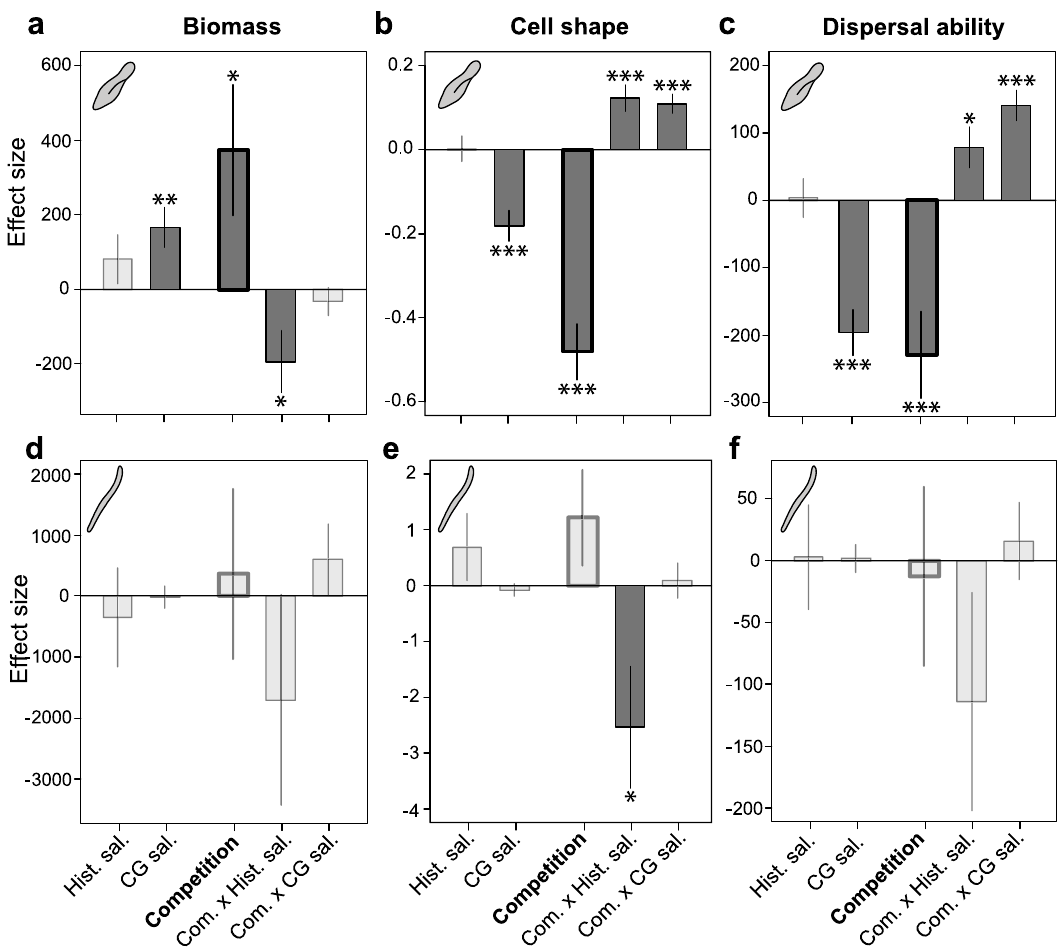
Figure 3. Factors affecting the phenotypic response to salinity. Effect sizes (difference in trait mean) and their standard errors for Paramecium aurelia ( a , c ) , and Spirostomum teres ( d , f ) obtained from a linear mixed effect model comparing traits of the species evolved in the absence and presence of competition using the common garden data (see “Methods”). Variables displayed are the salinity in which the species evolved in (Historical salinity; Hist. sal.), the salinity a species experienced during the common garden experiment (Common garden salinity; CG sal.), whether the species was evolved in the absence or presence of competing species (Competition), and interaction of competition with historical salinity and common garden salinity (Com. × Hist. sal. and Com. × CG sal., respectively). Measured traits were biomass, quantified as bio-area ( a , d ), cell shape, quantified as cell size ratio between the major and minor cell axis ( b , e ), and dispersal ability, quantified as gross speed ( c , f ). The competition effect is highlighted with bold bars. Significant effects are shown with dark grey bars and asterisks indicating the level of significance, with *p < 0.05, **p < 0.01, ***p < 0.001. Supplementary Figs. 3–4 show the robustness analysis of each of these effect sizes and p values. Supplementary tables S3 and S4 show the detailed results of the statistical